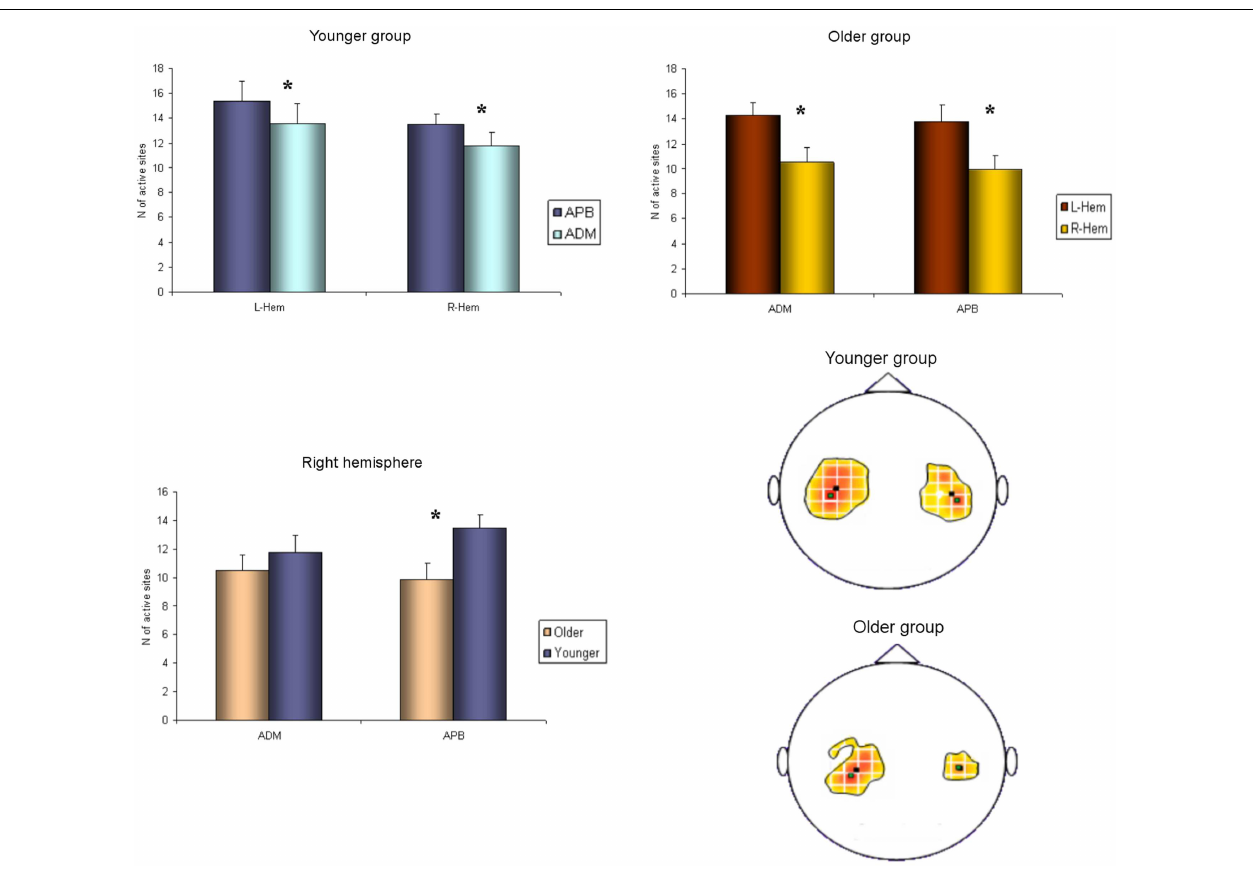
the significant reduction of the right hemisphere maps of both APB and ADM muscles, respected to the left hemisphere, in the older group.The lower part of Figure 2 represents the significant reduction of the APB map over the right hemisphere in the older group, compared to the younger group. * p <